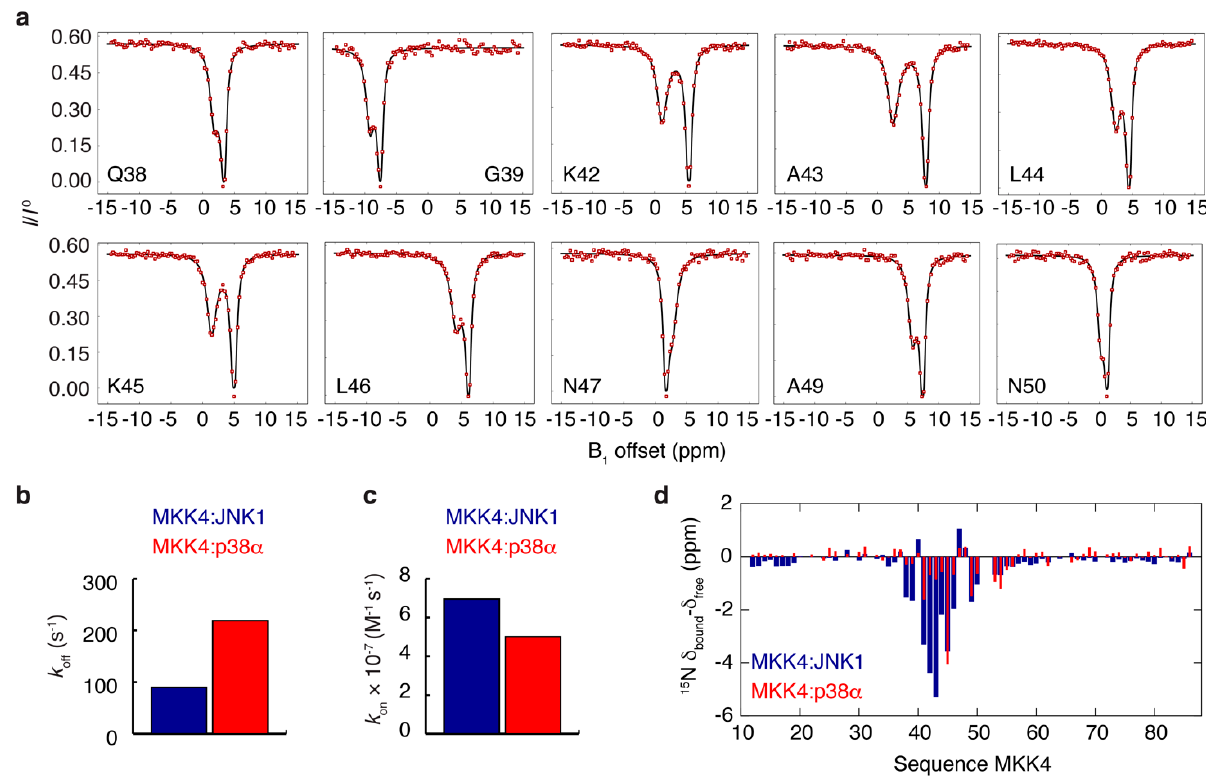
Figure 5. ( a ) 15 N CEST data of MKK4 in the presence of 10% molar ratio of JNK1. Red circles correspond to experimental data, while full drawn black lines correspond to a simultaneous analysis of the data according to a two-site exchange model. ( b , c ) Kinetic constants, k off ( b ) and k on ( c ), describing the interaction of MKK4 with JNK1 (blue) and p38 α (red). ( d ) 15 N chemical shift differences between the bound and free state of MKK4 derived from analysis of NMR exchange ex-periments (see main text).